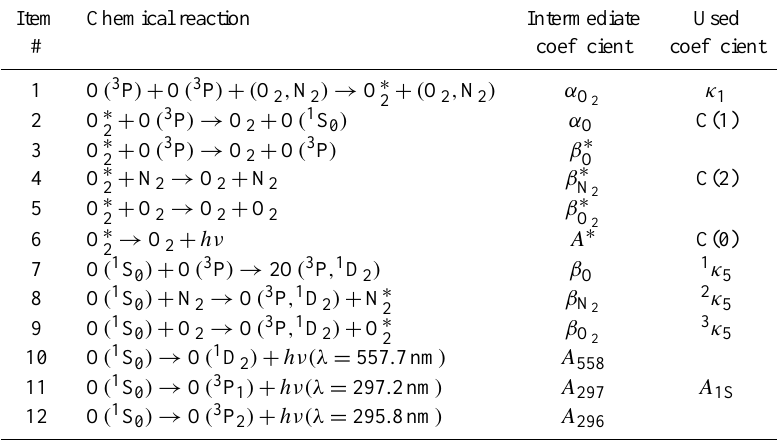
Table 1. Photochemical reactions according to the two-step Barth transfer scheme (see Reactions (1), (2) and the resulting Reaction (10) for the green line emission) accompanied by quenching. The quantities listed in the column named intermediate coefficients correspond to the notation by Khomich et al. (2008) and the coefficients employed here (see Eq. 15) follow the notation by Gobbi et al. (1992) and McDade et al. (1986) and are listed in the column entitled used coefficients . See Sect. 5 for further details. Item